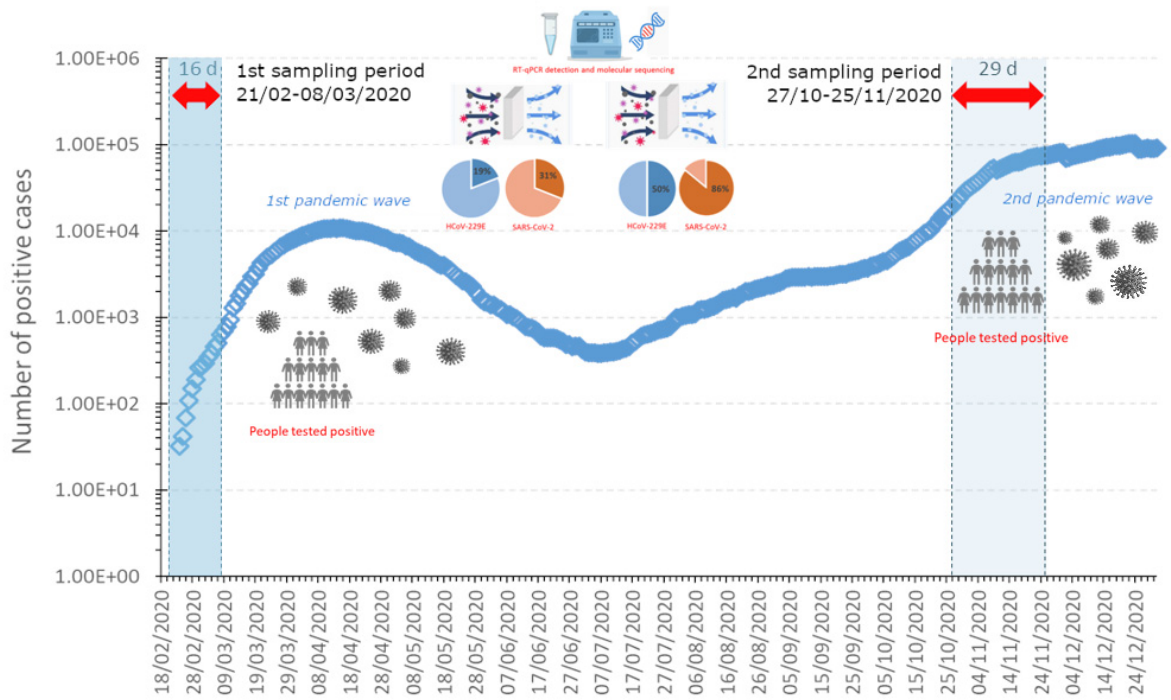
Figure 2. Local epidemic curve of SARS-CoV-2 (i.e., number of daily confirmed COVID-19 cases) for the Veneto region during the two PM sampling periods. First sampling period: 21 February–8